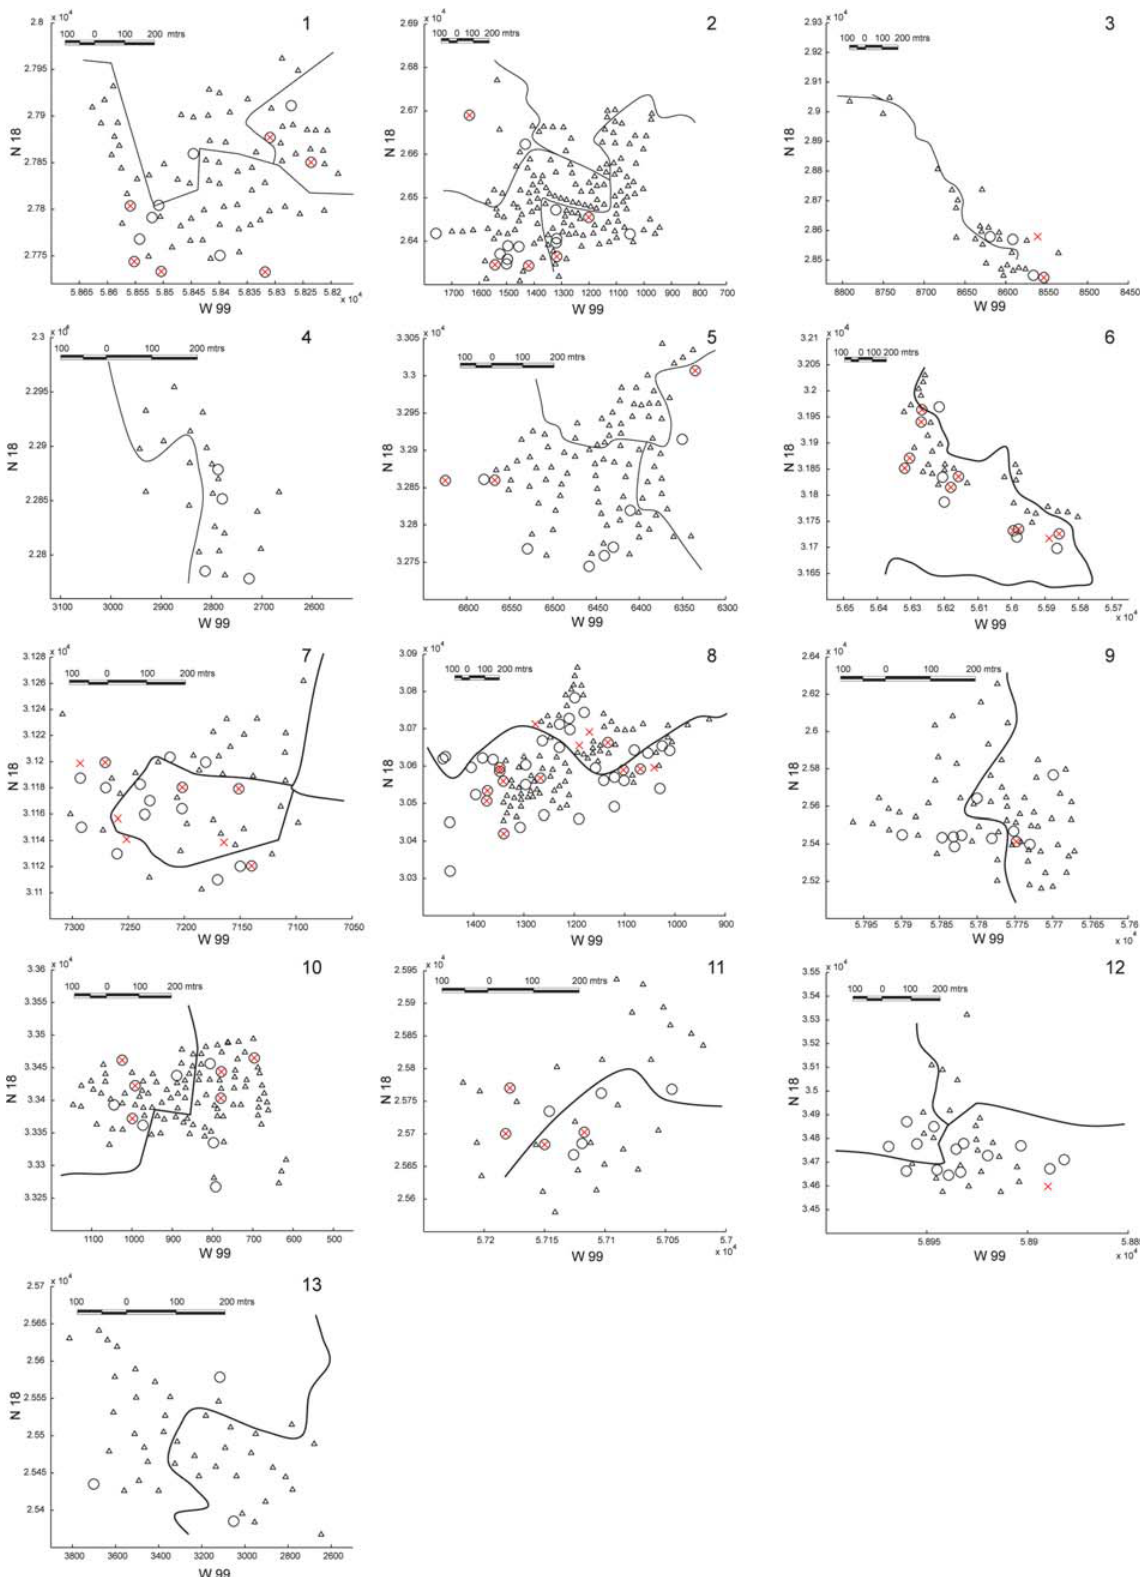
Figure 2. The geo-referenced location of the households with non-cysticercotic (O), cysticercotic ( 6 ), and both cysticercotic and non-cysticercotic pigs ( fl ) with a schematic representation of the position of households ( D ) in each of 13 villages in the study.